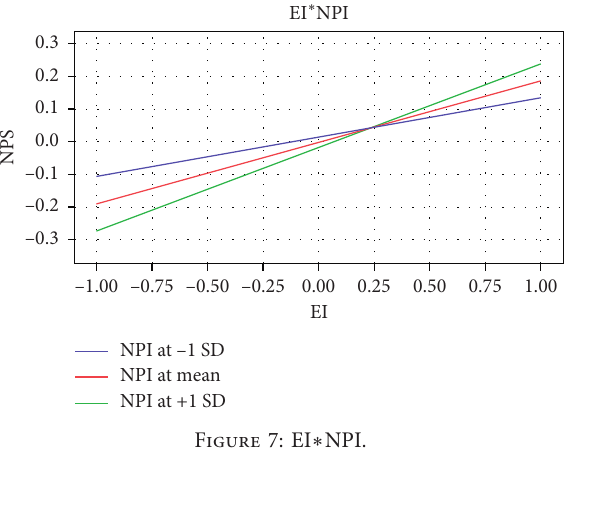
Figure 10: MC ∗ NPI. Figure 7: EI ∗ NPI.